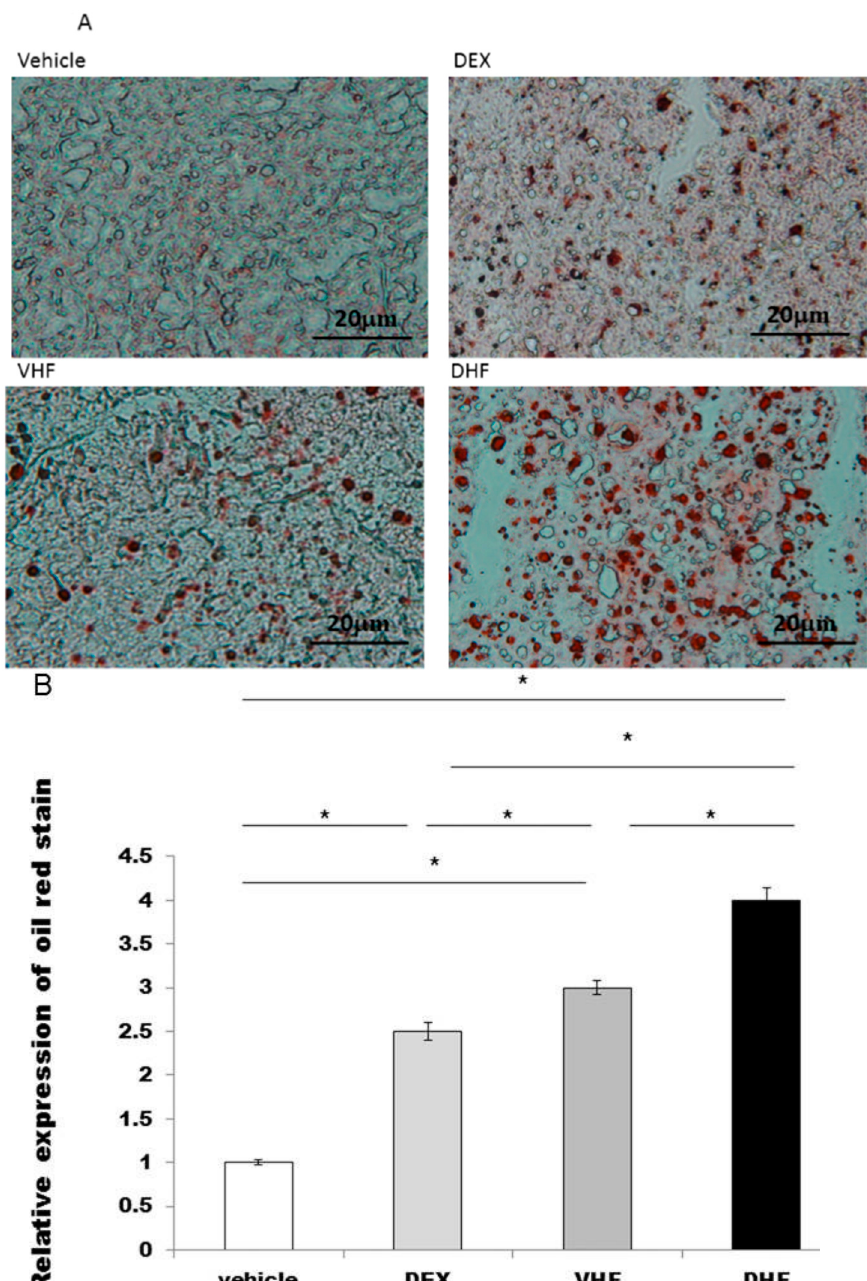
Figure 1. The liver steatosis was studied by oil red. ( A ) It was overexpressed in the prenatal dexamethasone (DEX) exposure plus postnatal high-fat diet group (DHF treated group), prenatal DEX exposure group (DEX treated group) and postnatal high-fat diet group (VHF treated group) than the vehicle treated group at ~180 day old rats; ( B ) Semi-quantification of the oil red stained cells. All the results represent mean ± standard error of six animals, * p < 0.05. The letters above each represented different groups with DEX representing the prenatal steroid treated; VHF treated group, postnatal HF diet group; DHF treated group, prenatal DEX exposure plus postnatal HF diet group (original magnification 400×; bar = 20 μ m).